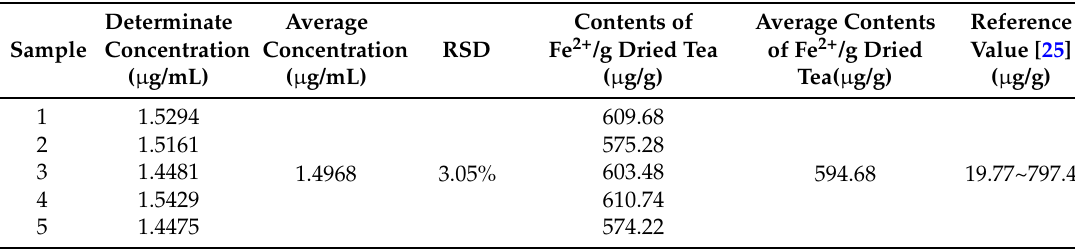
Table 1. Determination of Fe 2+ in Tieguanyin